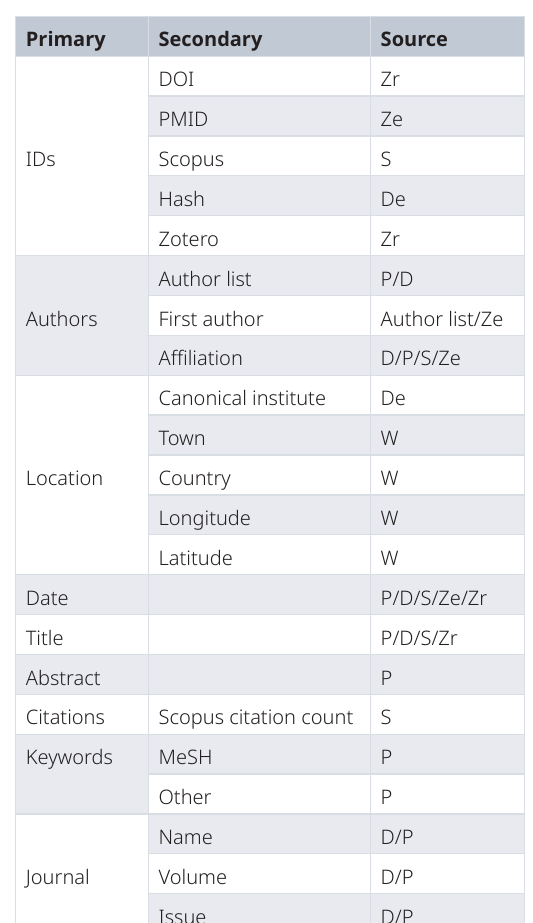
Table 1. Final metadata object. Tabular representation of the python dictionary used to store the metadata, the secondary column items are nested under the primary items where present.